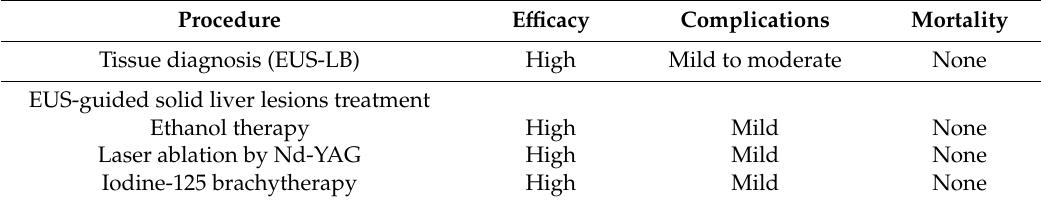
Table 3. Summary of e ffi cacy and safety of EUS-guided intervention in solid liver lesions. Procedure E ffi cacy Complications Mortality Tissue diagnosis (EUS-LB) High Mild to moderate None EUS-guided solid liver lesions treatment Ethanol therapy Laser ablation by Nd-YAG